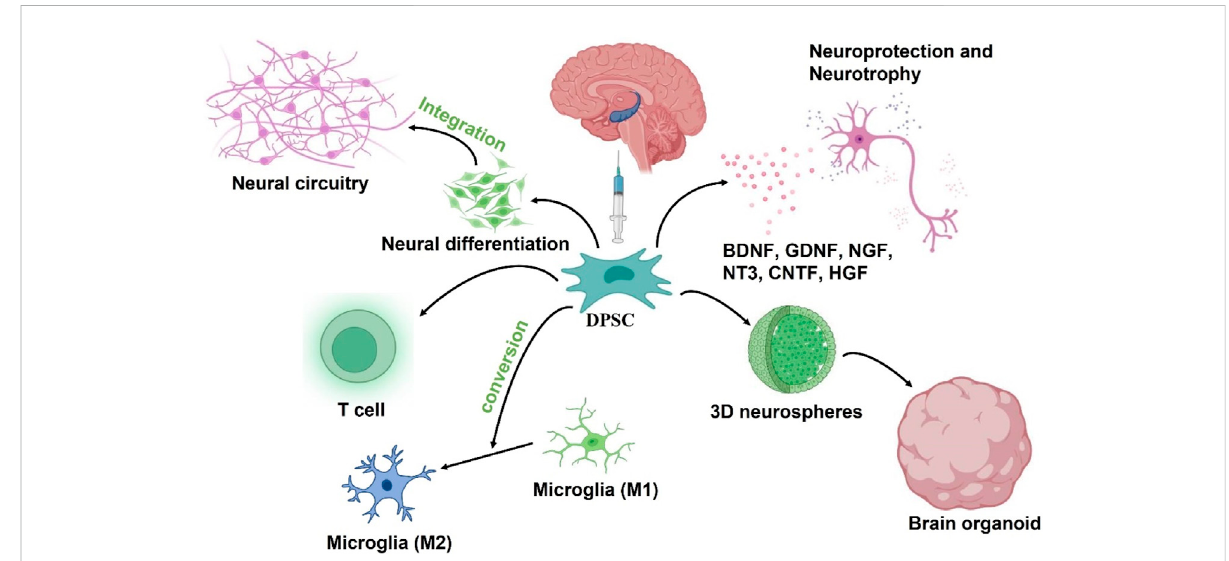
FIGURE 4 Putative DPSCs mechanism of action to treat AD: 1) Neural differentiation to replace damaged neurons, 2) Secretion of neuroprotective and neurotrophic factors, 3) neuroimmunomodulation. The engrafted DPSCs would differentiate into nerve cells to replace damaged neurons in the AD brainwhileintegratingintoexistingneuralcircuitry.Aftertransplantation,DPSCscouldalsoprotectneuronsinthebrainbysecretingneuroprotective and neurotrophic factors, and also drive the polarization of macrophages toward M2 phenotype to regulate neuroin fl ammation in the microenvironment. In addition, DPSC can bedeveloped into brain organoidthrough neural inductionand 3D culture schemesfor in vitro simulation